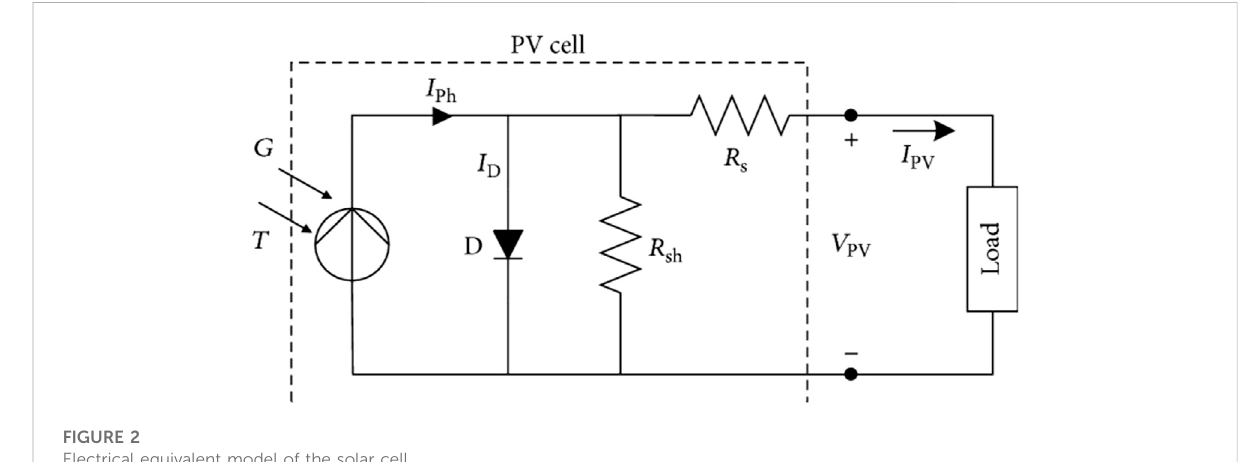
FIGURE 2 Electrical equivalent model of the solar cell.